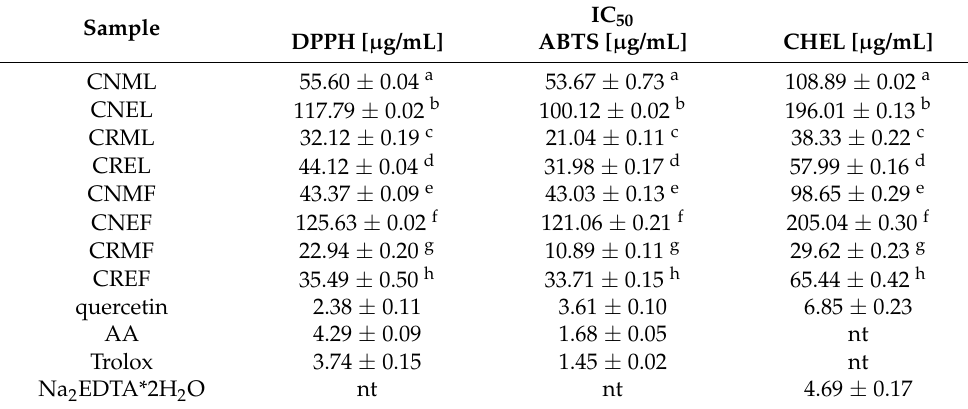
Table 4. The IC 50 values determined in antioxidant